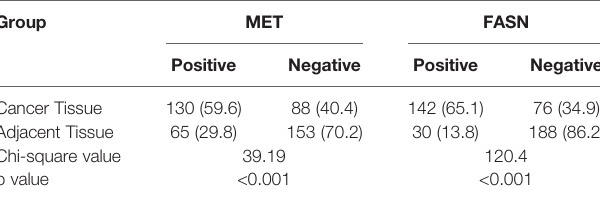
TABLE 2 | Expression of MET and FASN in cancer and adjacent